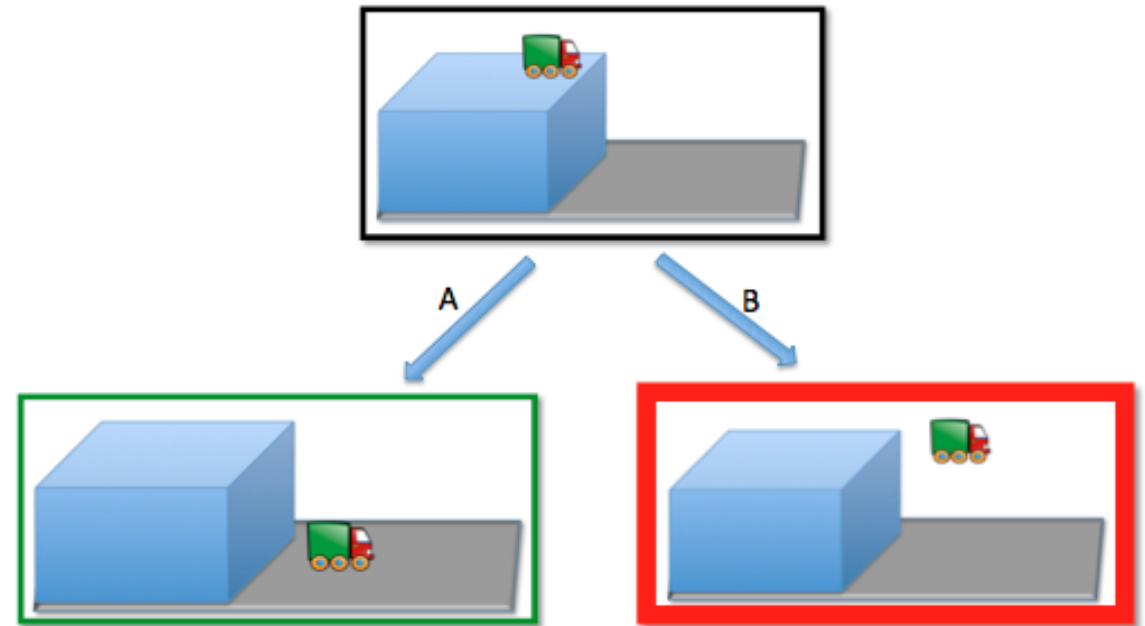
Figure 2. Common paradigm testing infants’ understanding of support relations. After the truck is pushed off the ramp, it either falls to the table (Scenario A) or appears to float in mid-air (Scenario B). Infants stare longer at the incongruent event where the truck does not fall when support is removed, as discussed by Stahl and Feigensen